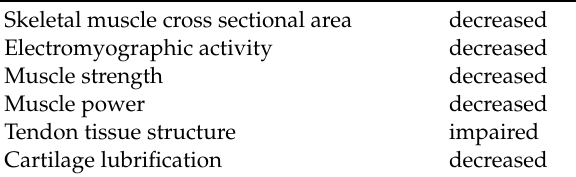
Table 1. Skeletal muscle–tendon–cartilage changes after long term